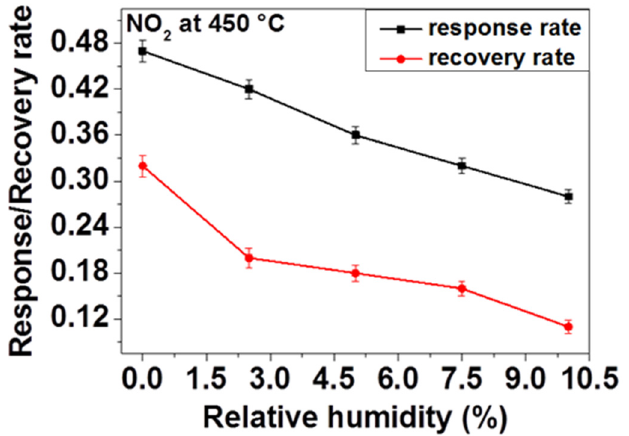
Figure 9. NO 2 response and recovery rate of ZnO thin film at 450 °C in the presence of different relative humidity.